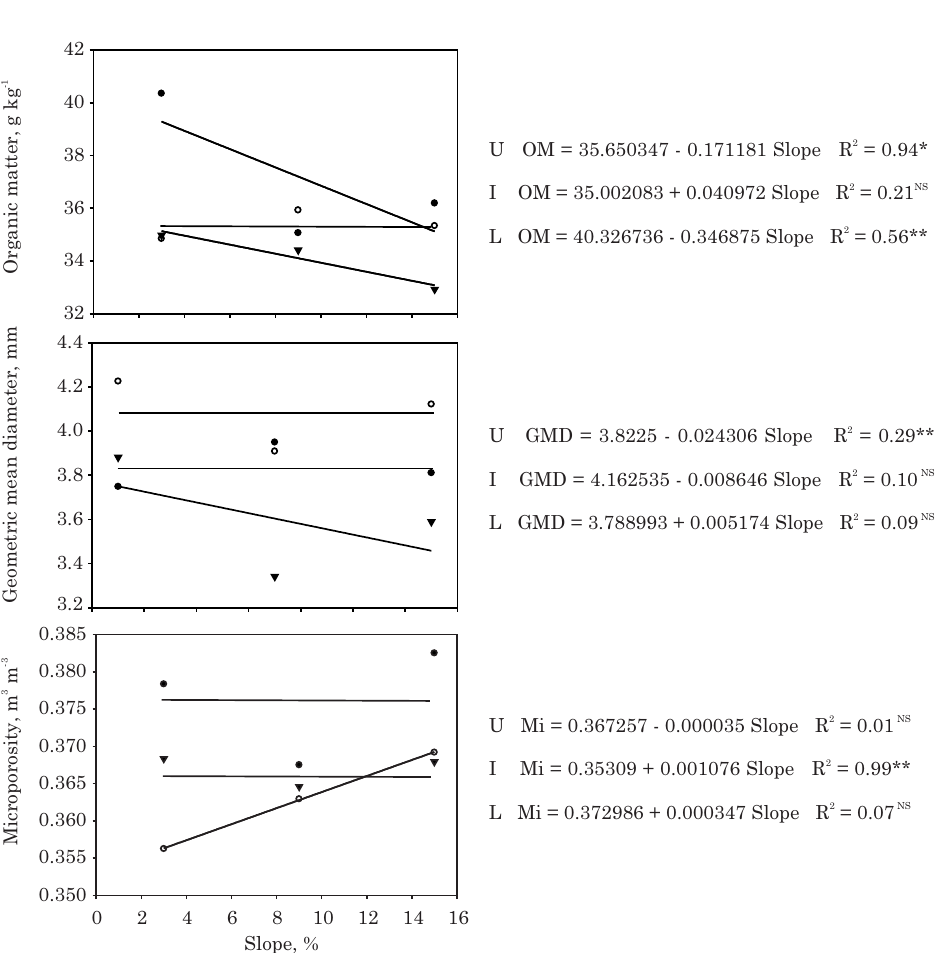
Figure 3. Effect of the interaction between slope and sampling position on organic matter, aggregate stability by mean geometric diameter and microporosity (data are means of all four ages at two depths). qqqqq Upper track (U), Inter-row (I) and lllll Lower track